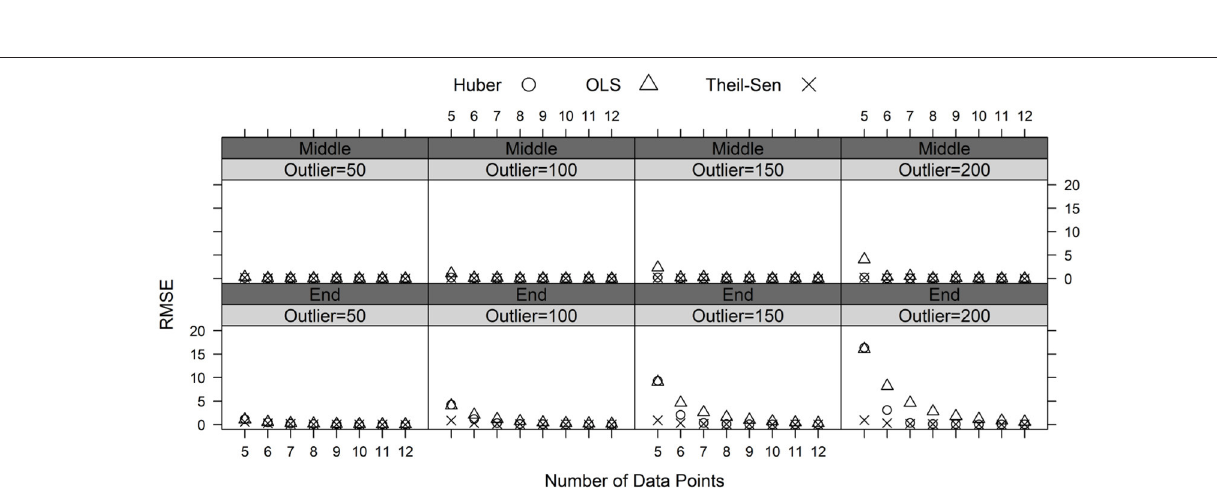
Frontiers in Education |